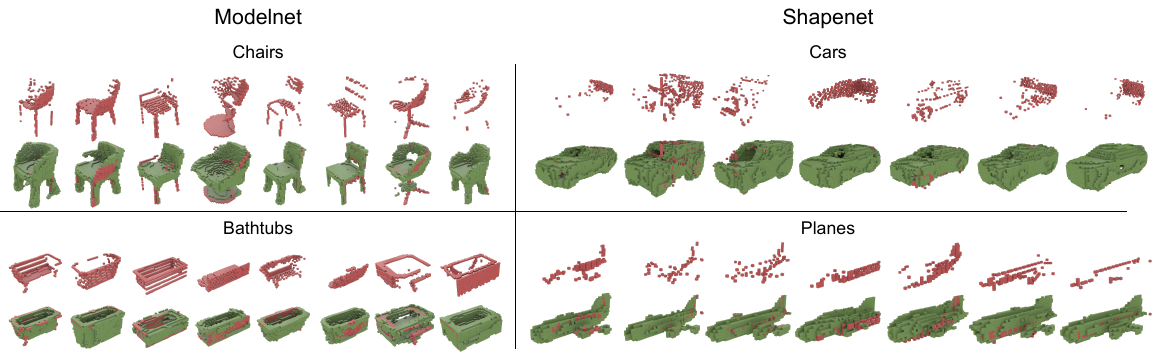
Figure 5. Predicted shapes for ModelNet chairs (top left), bathtubs (bottom left), ShapeNet cars (top right), and ShapeNet airplanes (bottom right). All networks were trained on very sparse samples. Red voxels denote the input and green voxels the predictions. down to a vector of size 256, again with spectral normalization in each layer, see Fig.